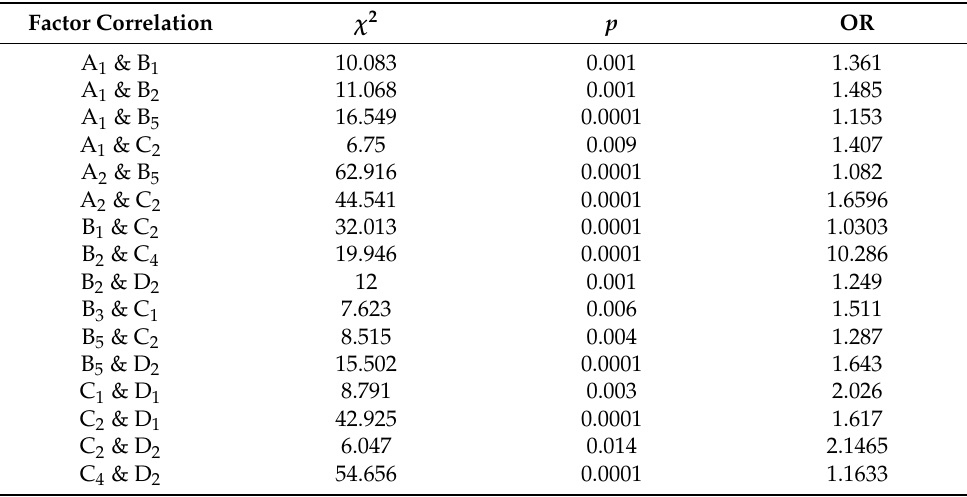
Table 3. Chi-square test and OR values statistics table. Factor